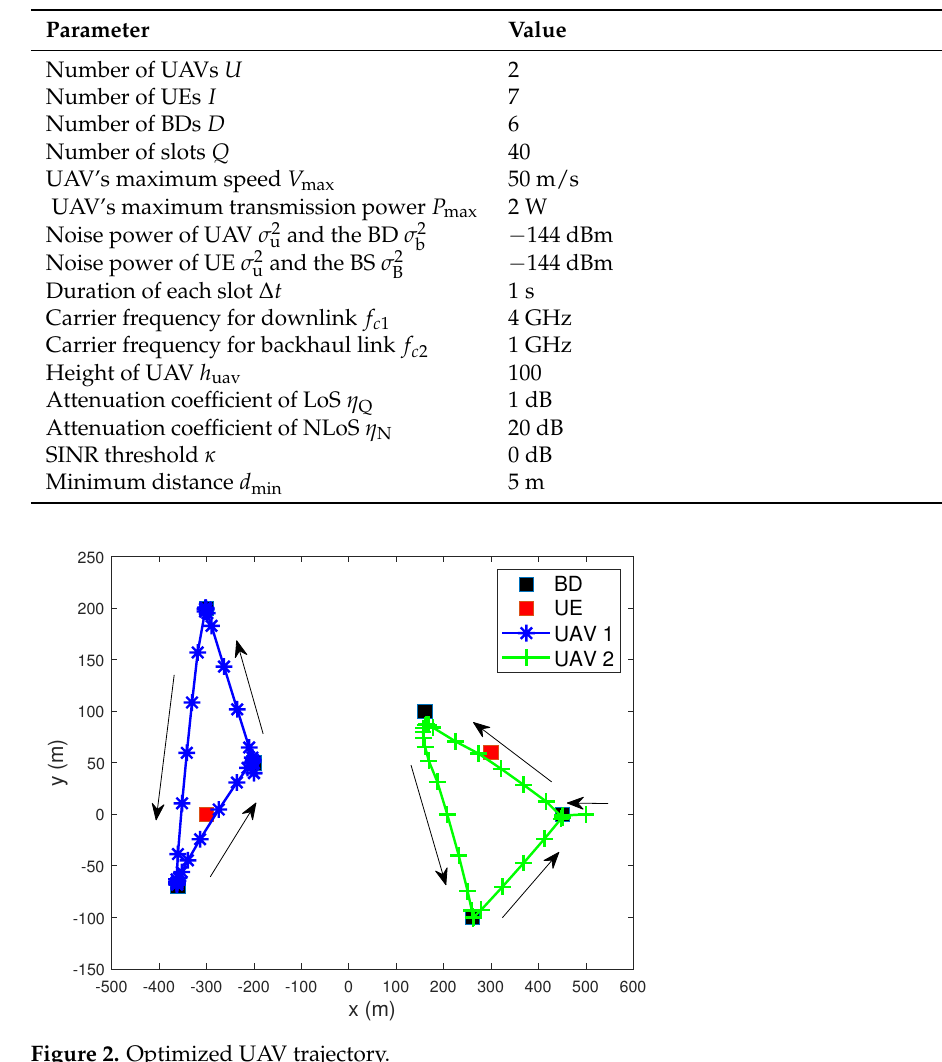
Table 1. Simulation parameters.